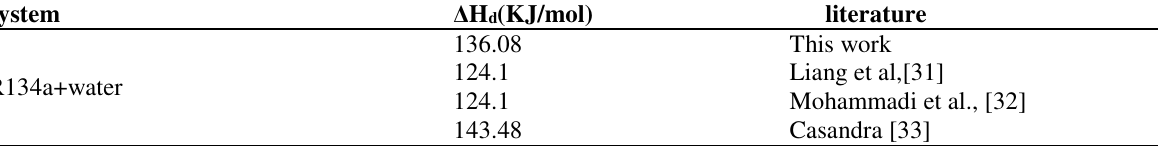
Table 3, Experimental and literature data of the enthalpies of dissociation for R134a+water binary system. system Δ H d